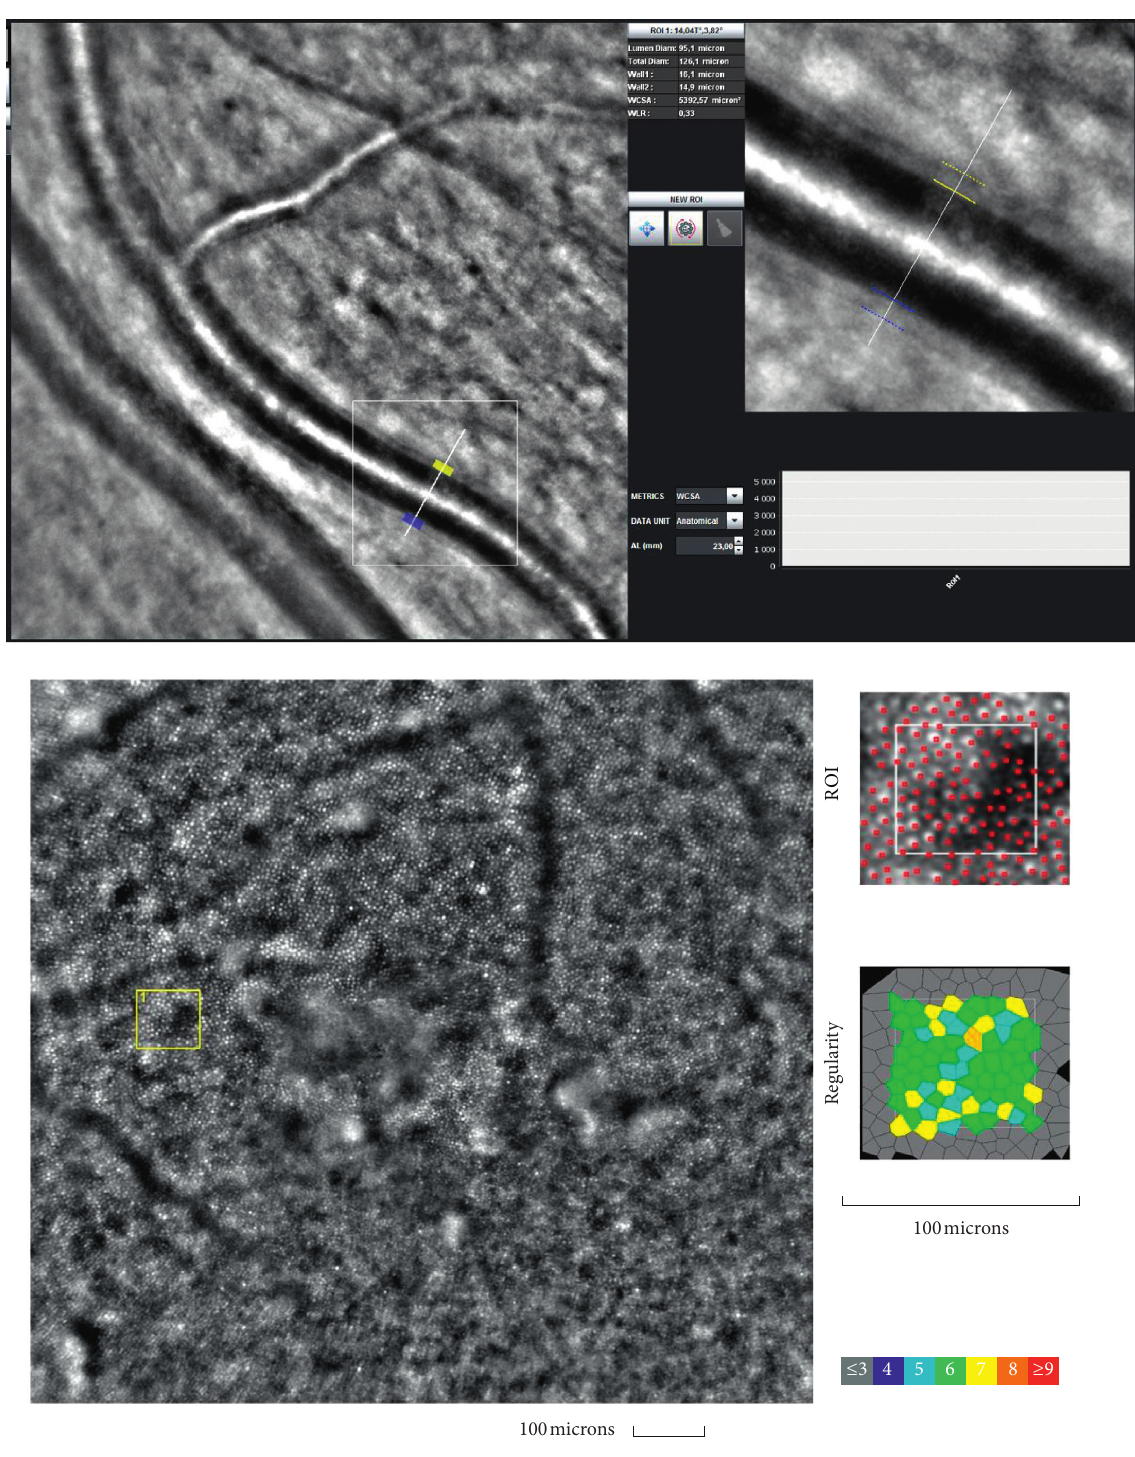
Figure 3: Image of the retinal artery (upper) and the cones mosaic window (cones depicted in red and Voronoi triangulation) (lower) for a BMI group patient (AR) captured by rtx1 AO retinal camera. The following parameters are shown: in the artery analysis; Lumen: 95.1 μ m, Total diameter:126.1 μ m, Wall_1:16.1 μ m, Wall_2:14.9 μ m, WLR: 0.33, WCSA: 5302.6 μ m 2 , AL: 23.00 mm; in the cone analysis: for different ROI (region of interest) squares: Regularity: 98.6%, Cone spacing: 7.89 μ m, Cone density: 19636 cone/mm 2